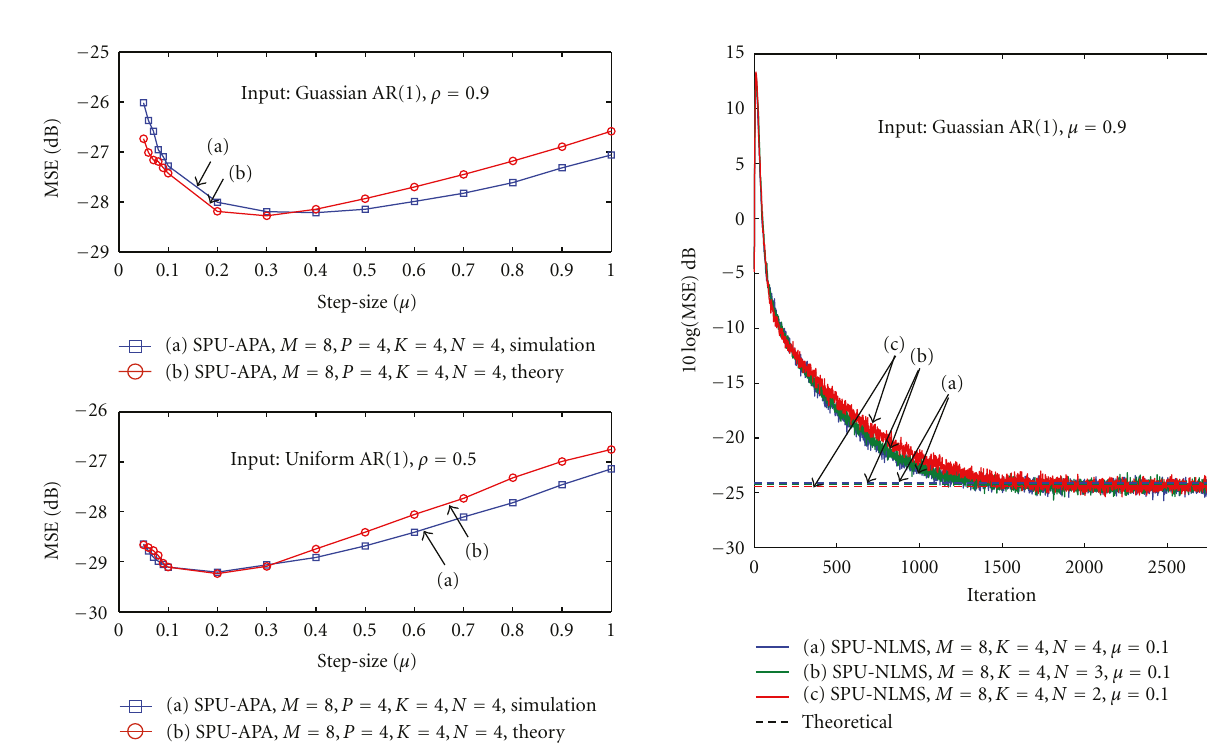
Figure 11: Steady-state MSE of SPU-APA with M = 8, P = 4, K = 4 and N = 4 as a function of the step size in nonstationary environment for di ff erent input signals.